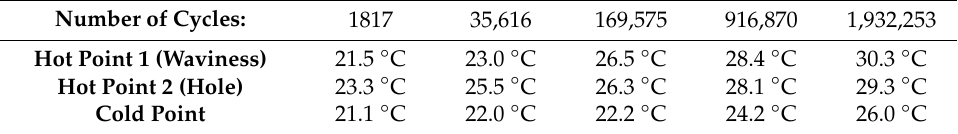
Table 4. Surface temperature for control points of the specimen cut in transversal direction with geometry B.